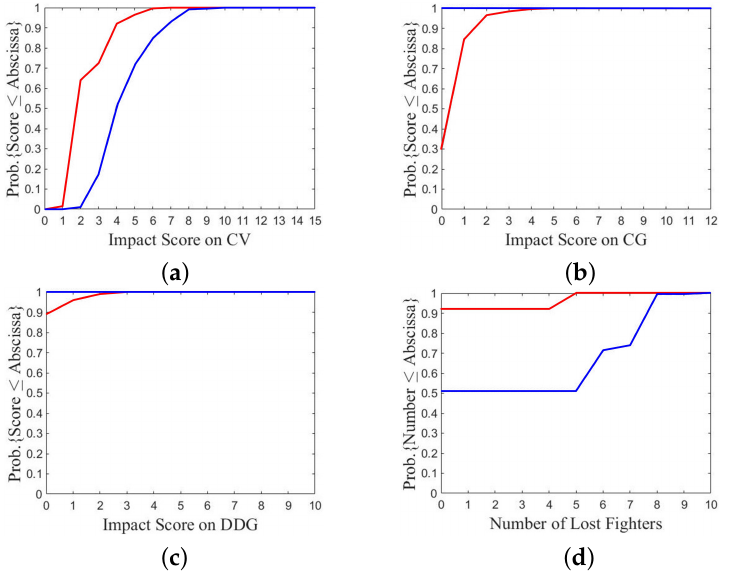
Figure 5. (A2/B3) Cumulative distribution of impact score on ( a ) CV ( b ) CG, ( c ) DDG, ( d ) fighters; over 200 games with one P 2 SO run, ———: fleet A, ———: fleet B.